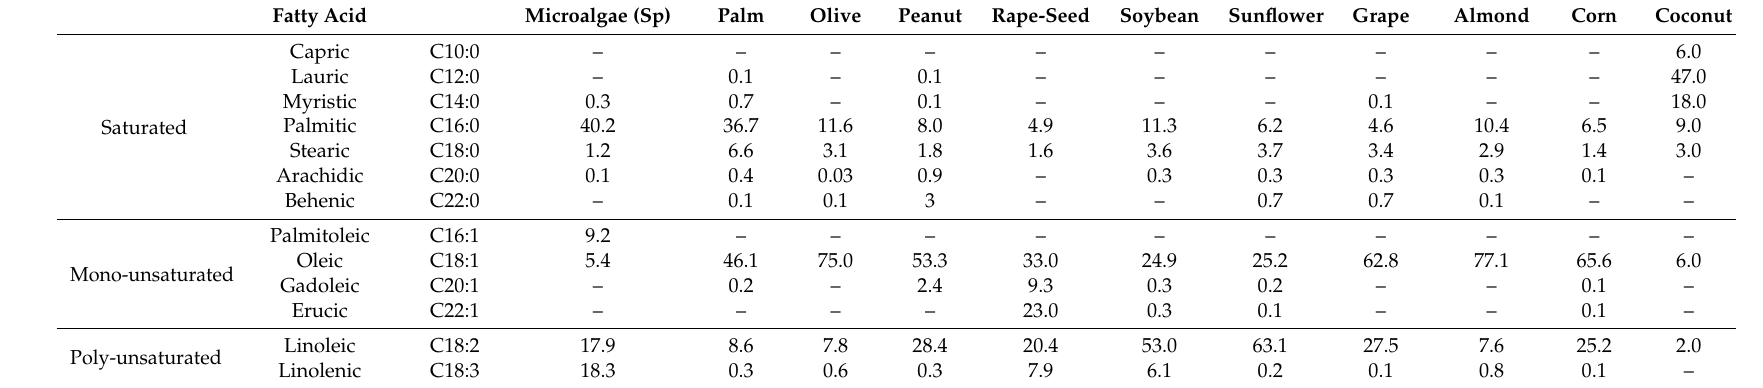
Table 2. Fatty acid compositions of various vegetable oils (modified from Reference